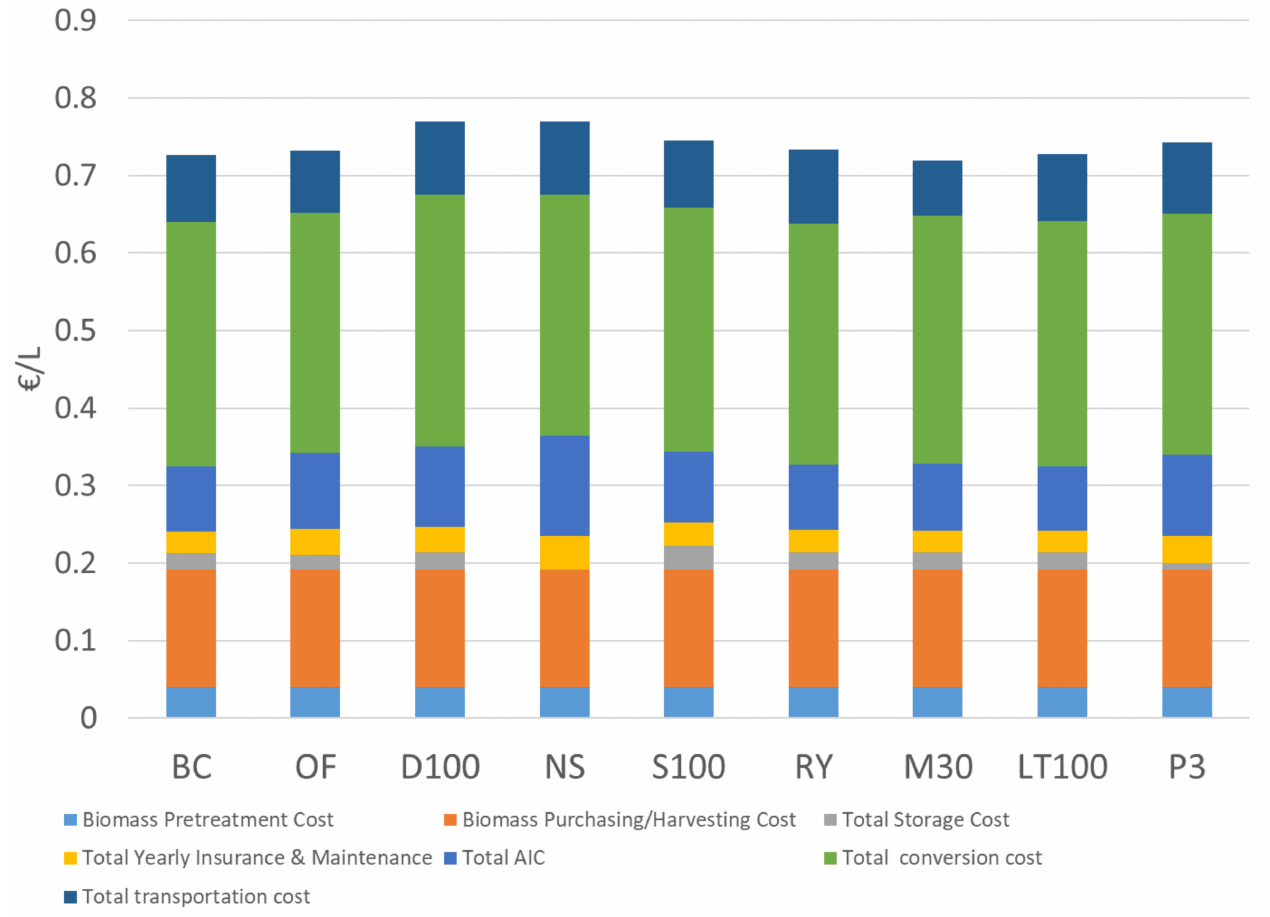
Figure 5. Cost breakdown of biofuel production.